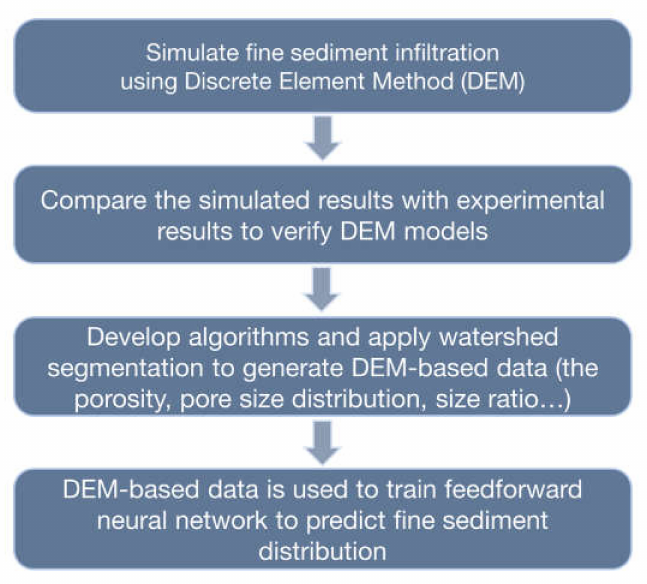
Figure 2. Schematization of fine sediment distribution prediction using discrete element method (DEM) and feedforward neural network